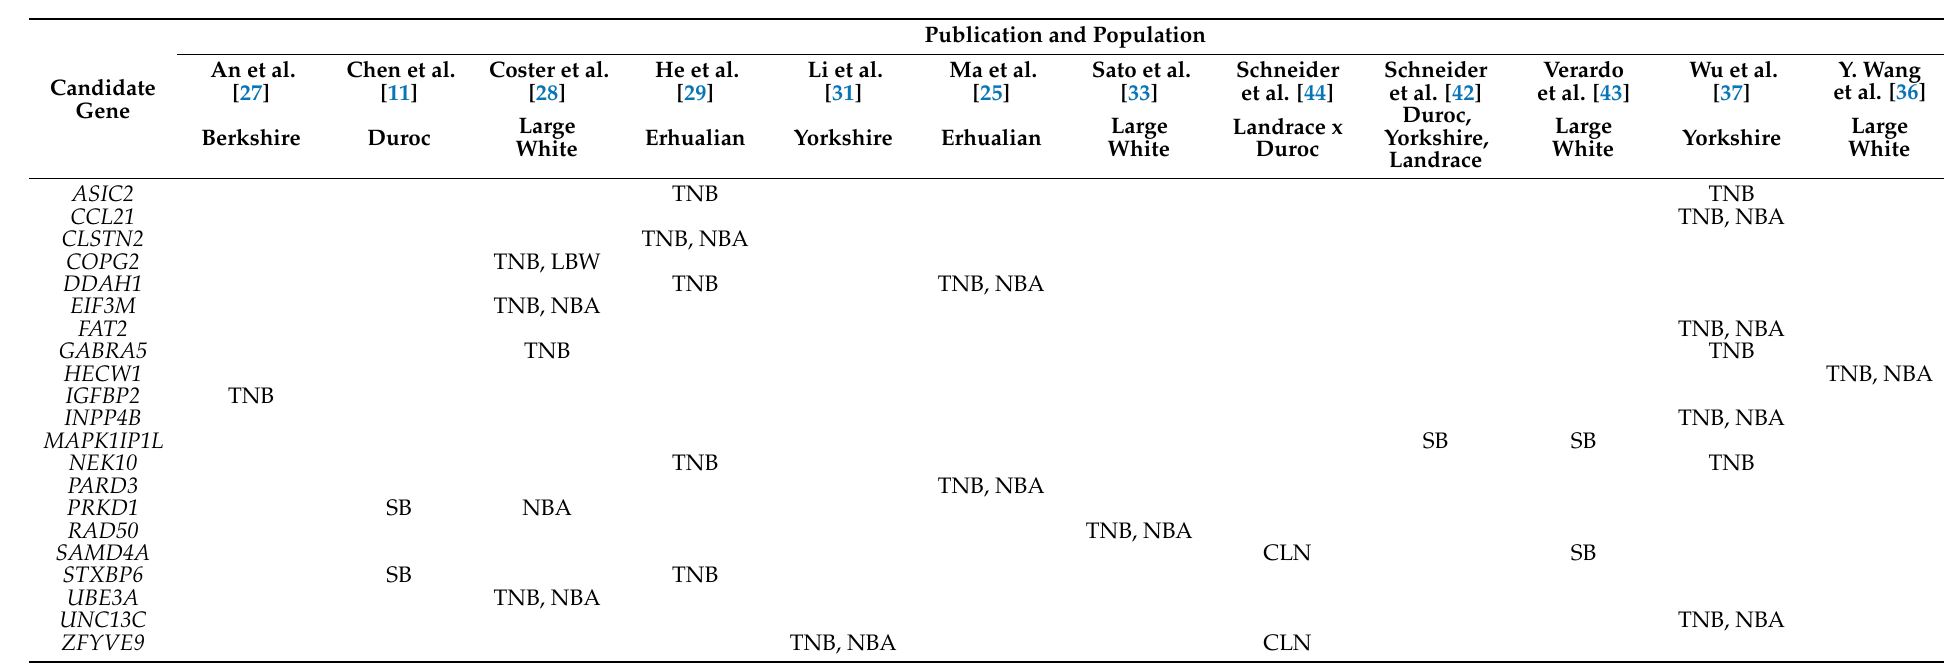
Table 4. Genes with at least two SNPs in their sequence associated with more than one of the reproduction traits: total number born (TNB), number born alive (NBA), number of stillborn (SB), or litter birth weight (LWT), or reported in more than one